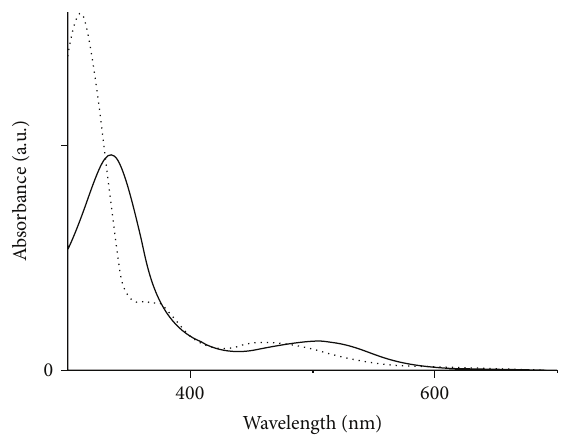
Figure 1: Electronic absorption spectra of 4-(2-ferrocenylv- inyl)pyridine (dotted line) and [CoCl(dmgH) 2 (fcvpy)] solid